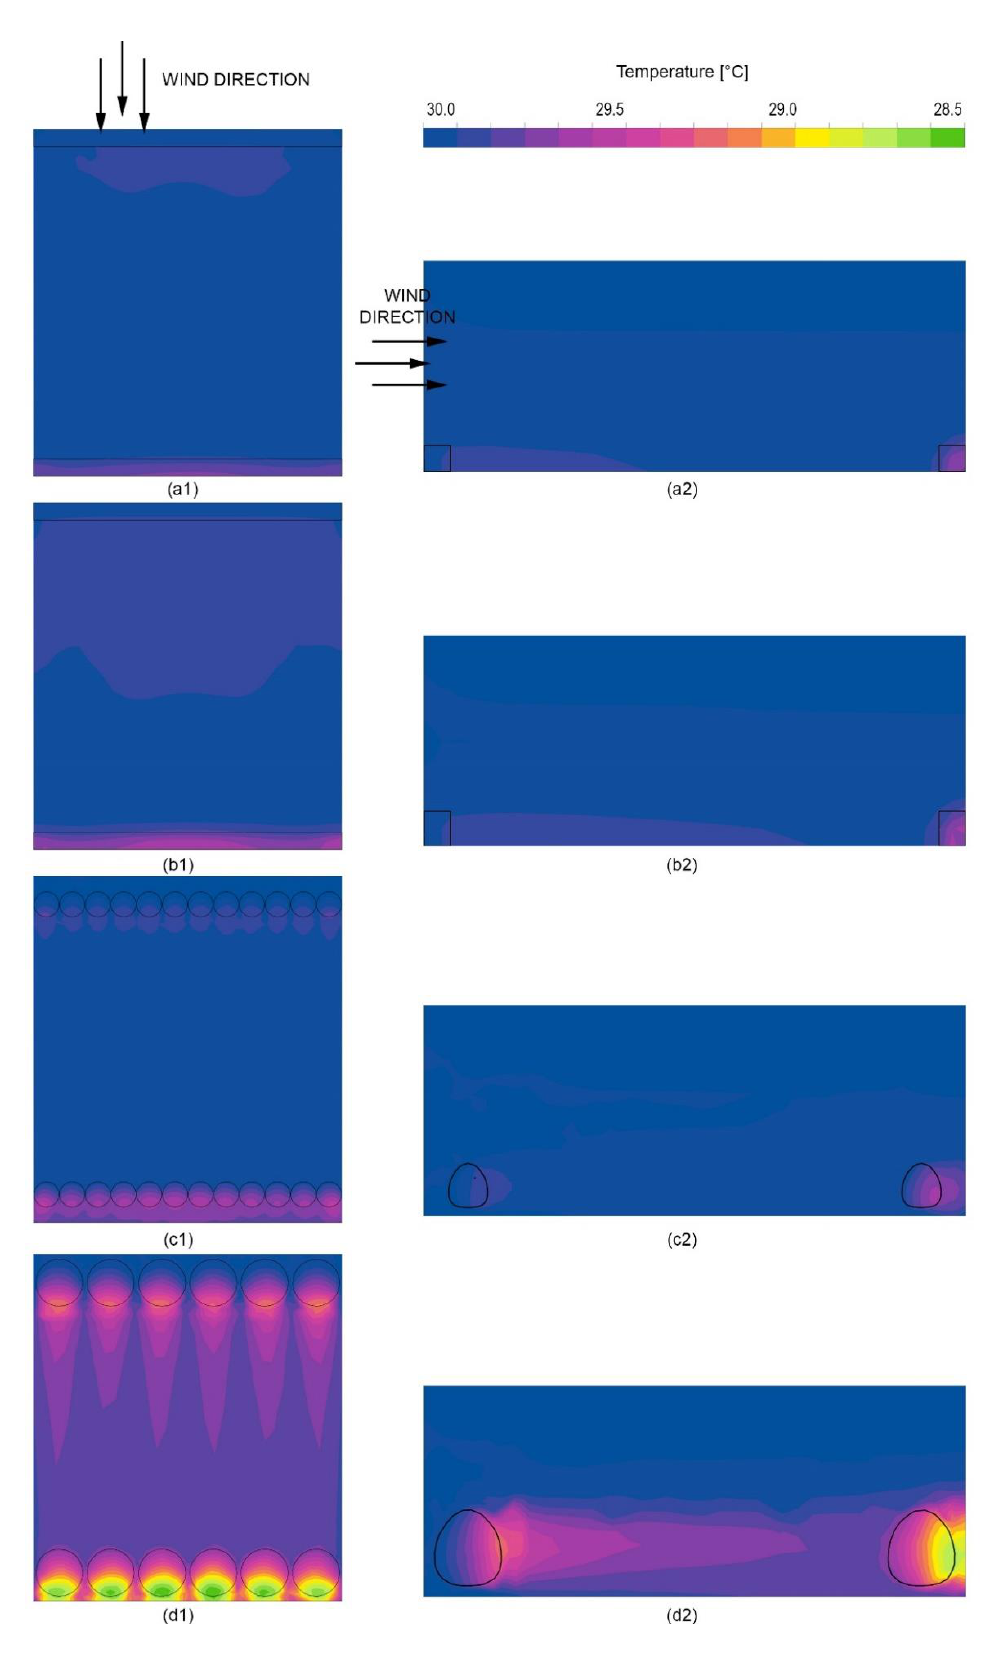
Figure 15. Temperature profile along the (1) horizontal and (2) vertical plane of the skygarden; ( a ) hedge 1.5 m, ( b ) hedge 2 m, ( c ) tree 2.5 m, and ( d ) tree 5